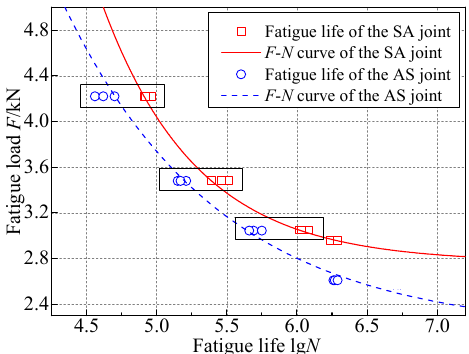
Figure 10. F - N curves of the SA joint and the AS joint.